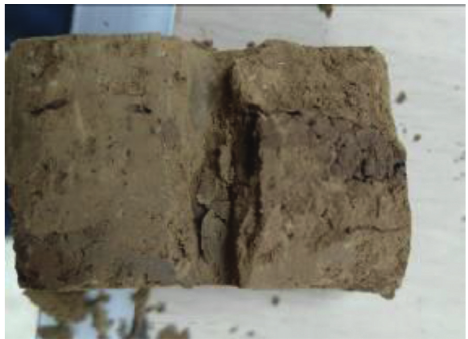
Figure 5: Failure pattern of loess along the drilling